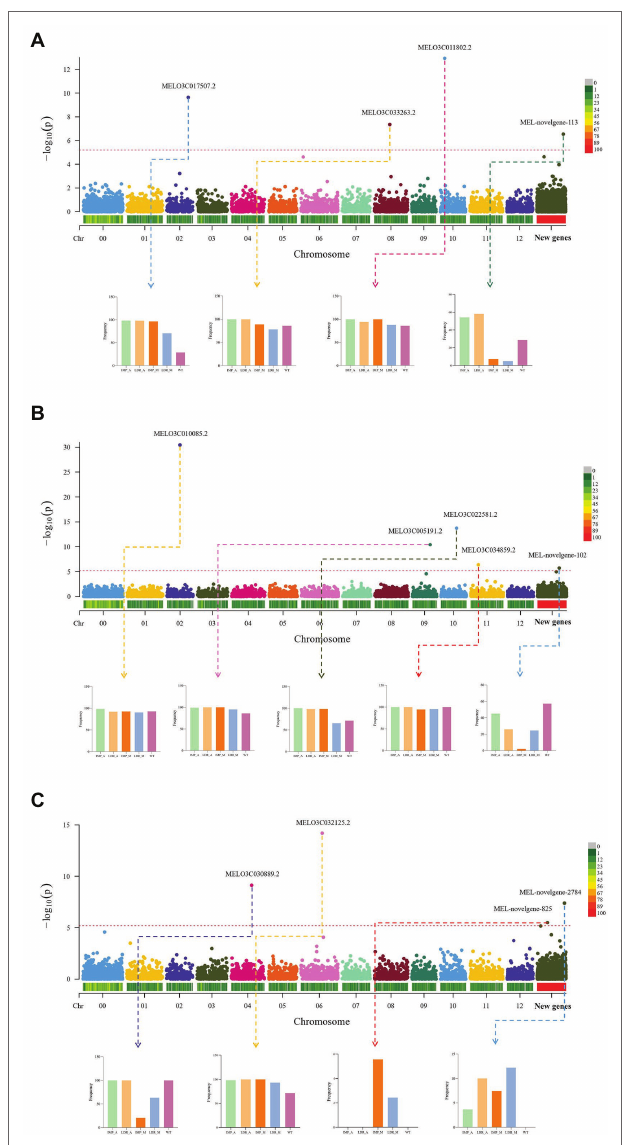
FIGURE 5 | Gene PAV-based genome-wide association analysis (GWAS) of (A) fruit length, (B) fruit shape, and (C) fruit width. The histogram represents the frequency of genes in different groups.